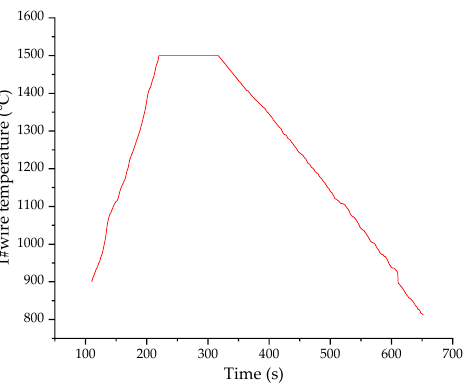
Figure 4. Diagram of the temperature–time curve obtained by the image processing method.